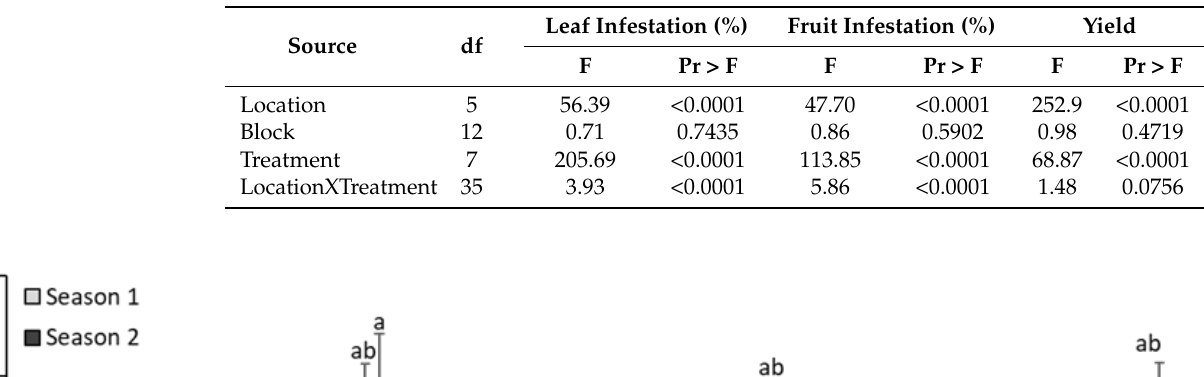
Table 4. Combined analyses for leaf and fruit infestation by Tuta absoluta and yield in tomato for six locations (2 years, three provinces) in Andhra Pradesh, India during two growing seasons (May – August 2018, September – December 2018)